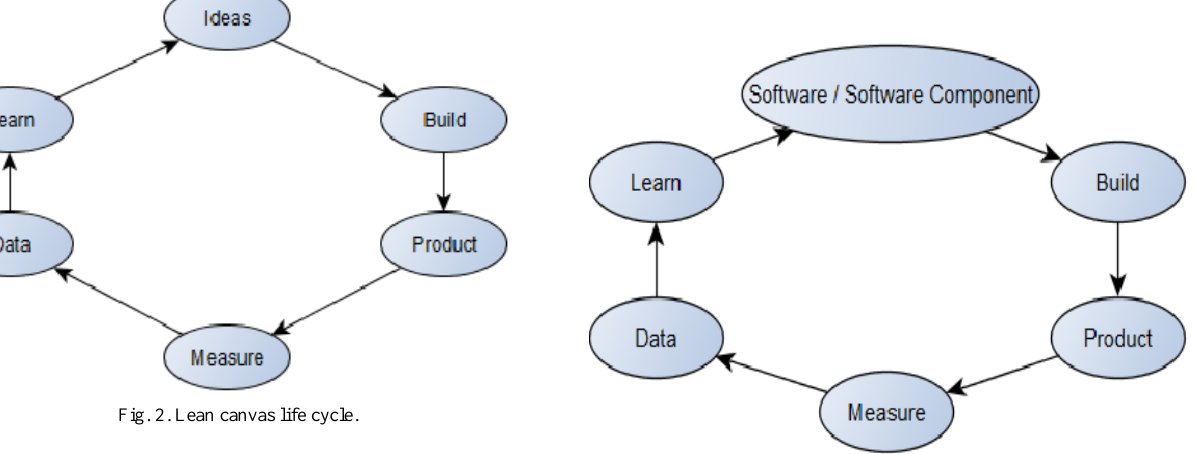
Fig. 3. Abstract of lean canvas life cycle to lean test canvas life